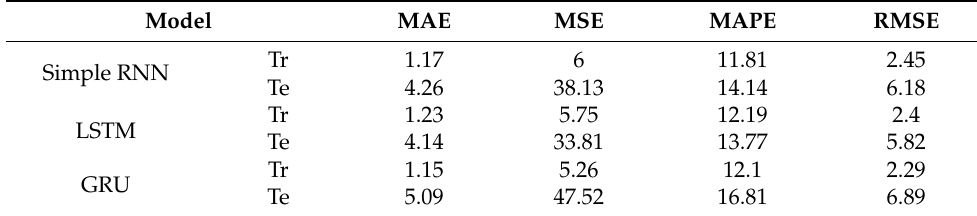
Table 3. Performance of the proposed models.